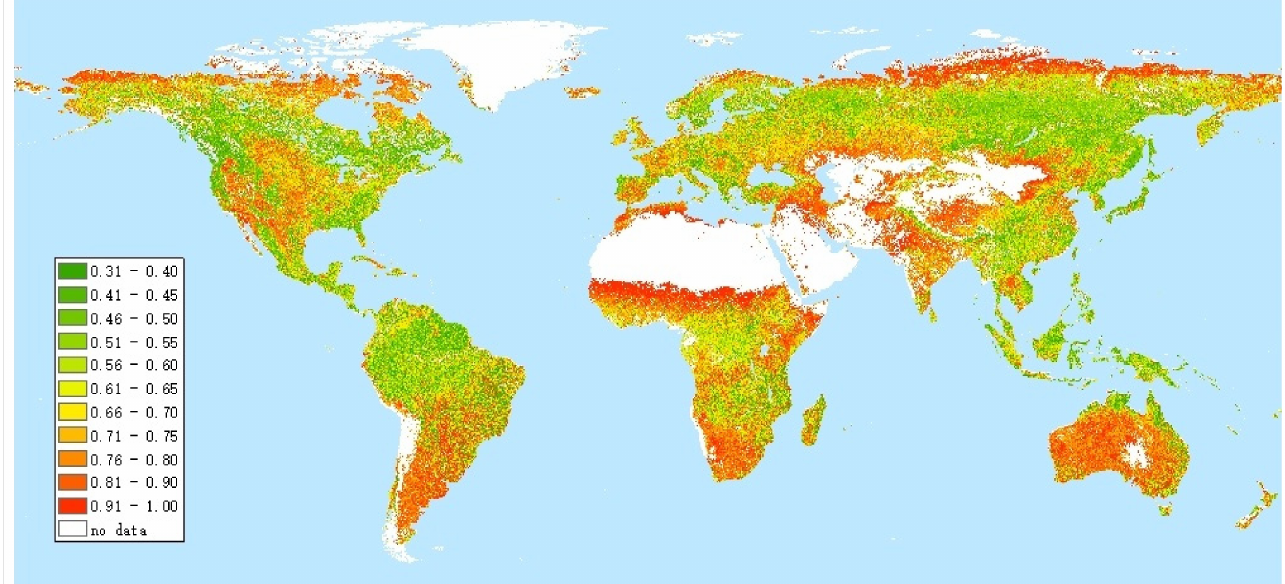
Figure 4. A global CI map on 4–11 July 2015 derived from MODIS BRDF data at 500 m resolution as an